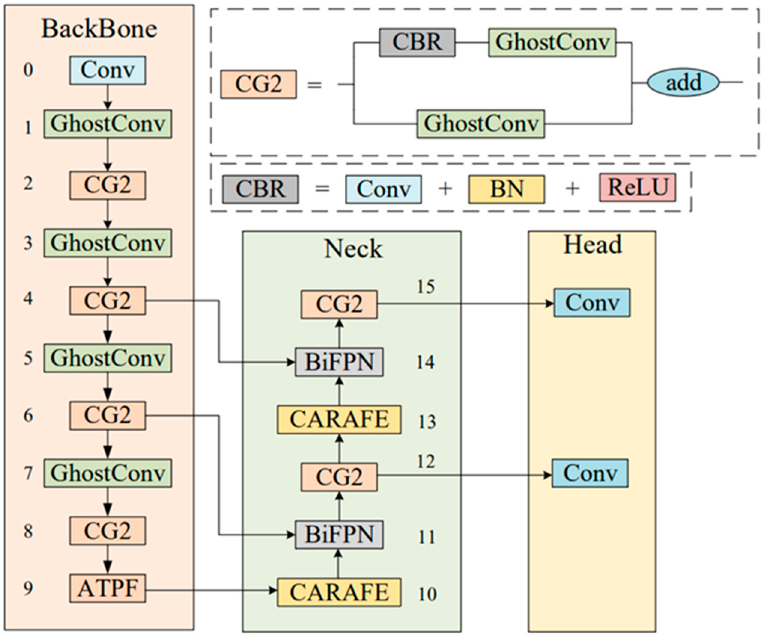
Figure 2. Network structure diagram of CG-Net.